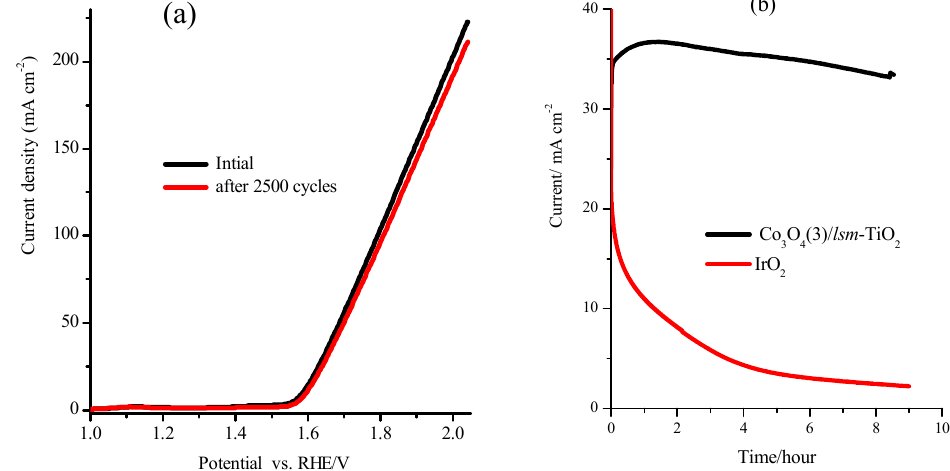
Figure 6. ( a ) LSV curves at 10 mV s − 1 for the first and after 2500 cycles of Co 3 O 4 (3) / lsm -TiO 2 electrode in 1.0 M of KOH solution; ( b ) the chronoamperometry of Co 3 O 4 (3) / lsm -TiO 2 electrode and the benchmark IrO 2 catalysts measured for 9 h at 1.65 V vs. RHE in 1.0 M KOH.